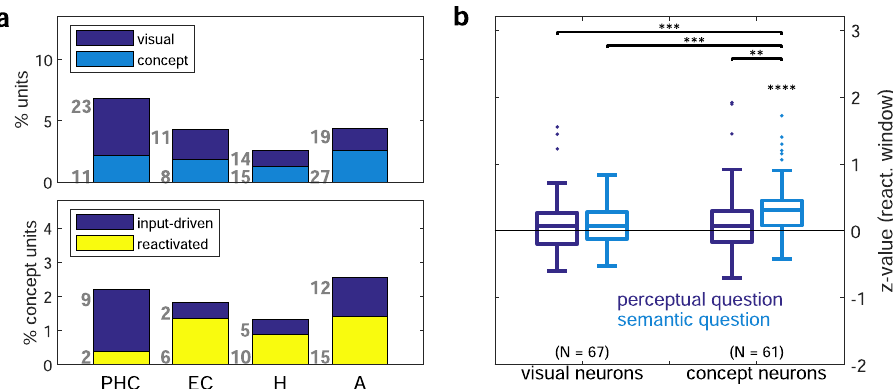
Fig. 4 Relational responses occur in brain regions associated with episodic memory and require conceptual processing. a Relative frequency of each neuron type expressed as percentage of recorded units for different brain regions (PHC parahippocampal cortex, EC entorhinal cortex, H hippocampus, A amygdala). Top: Visually selective neurons are divided into concept and non-concept (visually selective) neurons. Bottom: Concept neurons are split into reactivated neurons with relational responses and remaining input-driven neurons. b Boxplots of z-values (Q1, median, Q3; whisker: points within ±1.5 IQR) of average normalized relational response activity during the reactivation window of the main condition for merely visually selective versus actual concept neurons. Trials requiring semantic processing ( “ Bigger? ” , “ Last seen in real life? ” , “ More expensive/ Older? ” ) are colored in light blue, those depicting the perceptual question ( “ Brighter? ” ) in dark blue. Only relational responses of concept neurons during semantic questions deviated signi fi cantly from baseline ( p = 1.74 × 10 − 7 ; two-sided Wilcoxon signed-rank test against zero). Brackets with asterisks show results of pairwise two-sided Mann – Whitney U tests (uncorrected) between concept neurons (CN) or visual neurons (VN) in perceptual (p) or semantic (s) trials: p (CNs versus CNp) = 3.08 × 10 − 3 , p (CNs versus VNs) = 8.97 × 10 − 5 , p (CNs versus VNp) = 5.82 × 10 − 4 . **** p < 0.0001; *** p < 0.001; ** p < 0.01. Source data are provided as a Source Data fi